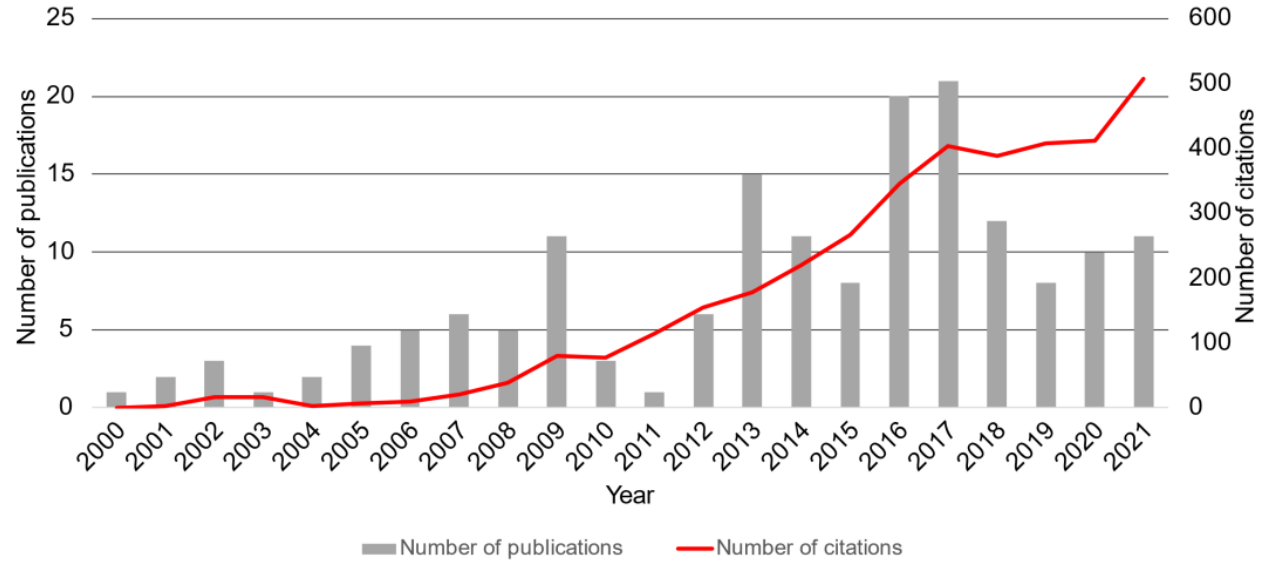
Figure 1. Number of publications and citations on solar adsorption chillers since the beginning of the 21st century. Authors' own study based on data from [12].